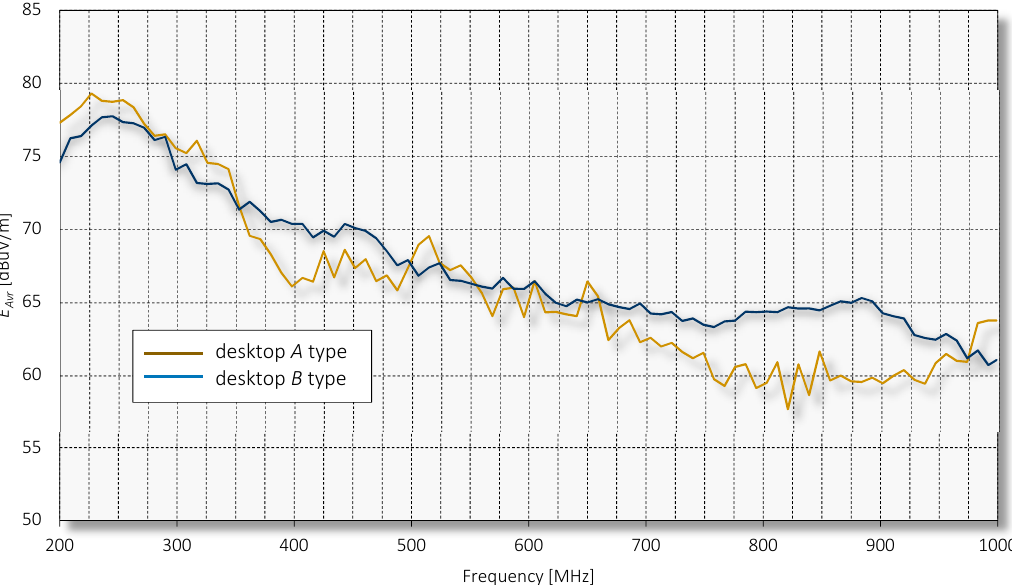
Figure 13. Average values of EM disturbances (valuable emissions) for two measured desktop computers in the range of frequencies from 200 MHz to 1 GHz.